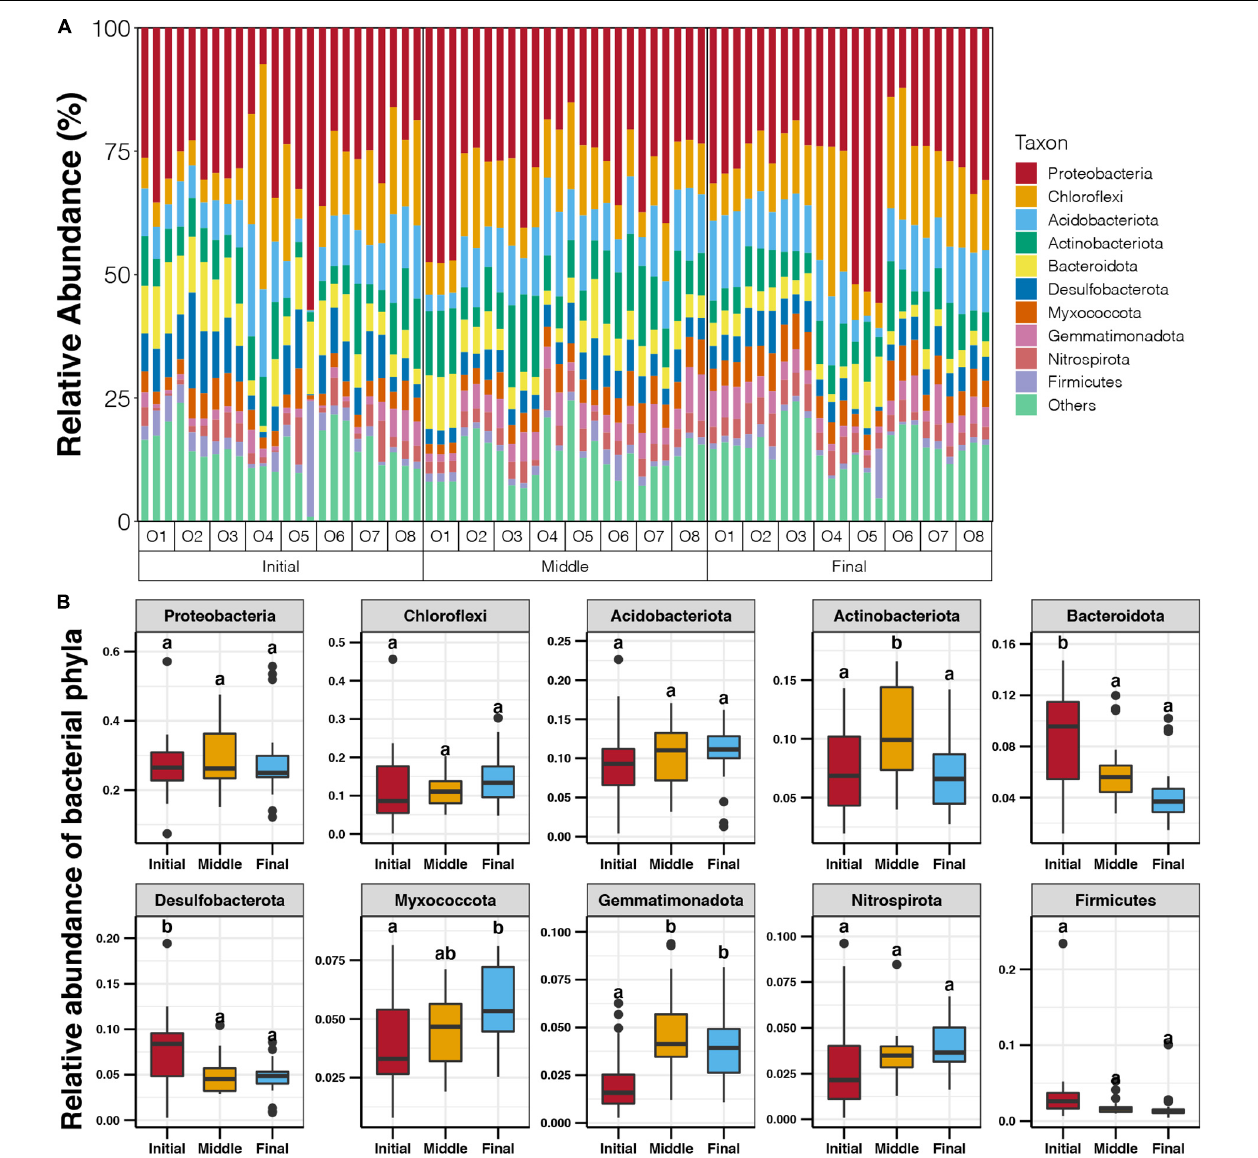
FIGURE 3 | (A) Relative abundance of dominant benthic bacterial phyla in the purification area of the IPRS at different locations during the culture cycle. (B) Variations in the relative abundance of dominant benthic bacterial phyla in the purification area of the IPRS during the culture cycle. Different lowercases letters above each box in the same subfigure represent significant differences between groups (Tukey’s HSD test, p < 0.05).